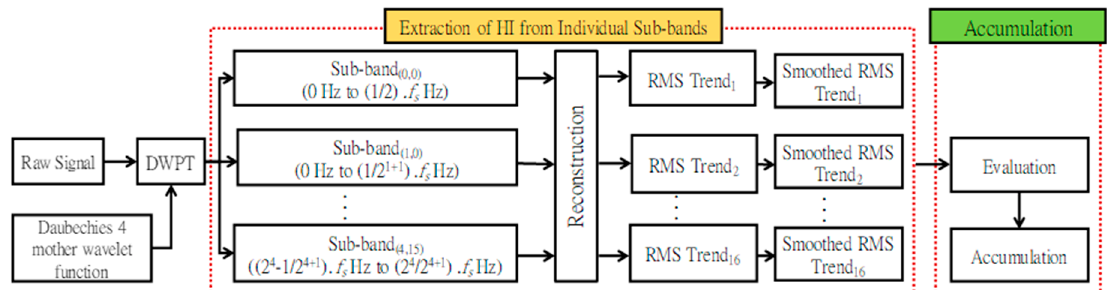
Figure 1. Proposed methodology for the construction of a bearing HI using sub-band analysis of the vibration acceleration signal.